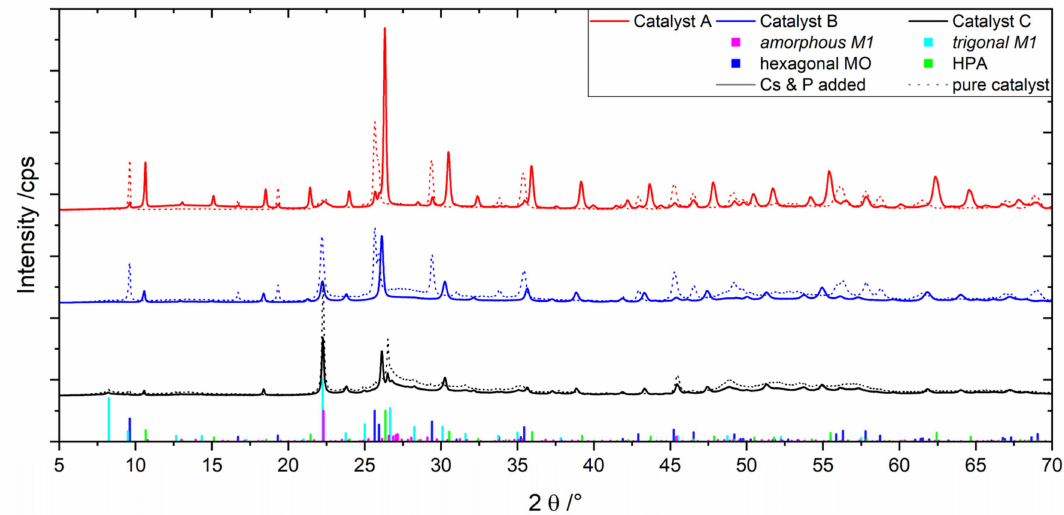
Figure 1. XRD pattern of the three catalysts prior to (dots) and after (solid line) adding Cs & P in a (Mo + V + W)/Cs and (Mo + V + W)/P ratio of 18. Characteristic XRD reflexes of amorphous M1-phase (magenta bars), trigonal M1-phase (cyan bars), h-phase (blue bars) and HPA (green bars). Table 1. Chemical composition, specific surface area, crystallinity and estimated phase composition of the catalysts A, B and C prior to and after adding Cs and P in a (Mo + V + W)/Cs and (Mo + V + W)/P ratio of 18. Chemical h-Phase M1 HPA Catalyst A BET (m 2 /g) Cryst. (wt.%) Composition (wt.%) * (wt.%) * (wt.%) *